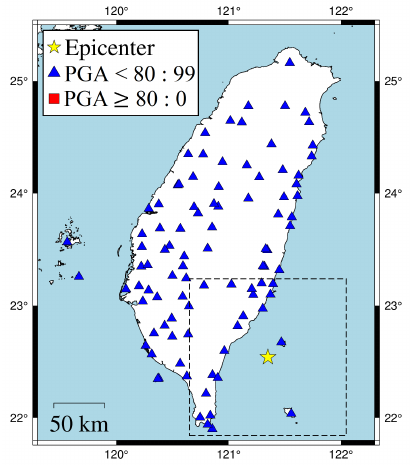
Figure 8. Comparison of ISMP and Pd schemes using different time windows for the 18 April 2021 Hualien event. The first and second rows are the prediction results of the ISMP and Pd schemes, respectively. The third row shows the histogram of the leading time in TP records using the two schemes. The yellow star represents the event epicenter. The triangles are the stations with actual PGA < 80 Gal and the squares are the stations with actual PGA ≥ 80 Gal, where the blue and red colors represent stations that make correct and false predictions, respectively.